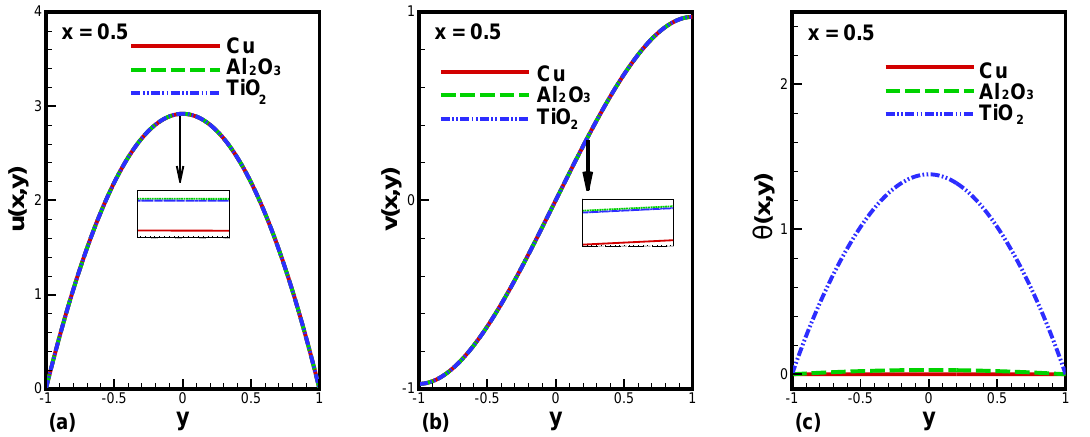
Figure 6. Variation of different nanoparticles on dimensionless ( a ) longitudinal, ( b ) transverse velocities, and ( c ) temperature profile at the middle region of the channel, when β = 0.5, φ = 0.05, B r = 6, P e = 1, δ = 0.2, R e = 1, and γ =